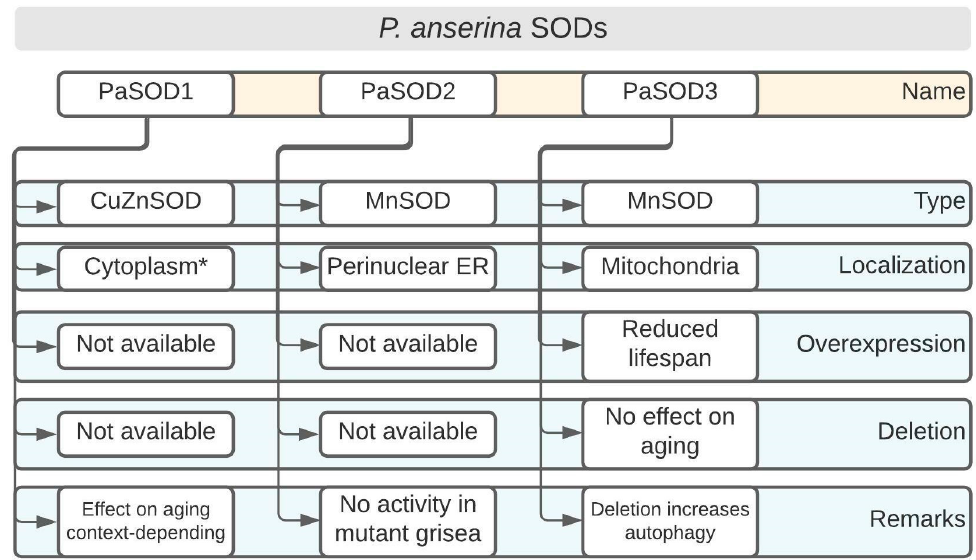
Figure 2. Podospora anserina SOD overview. * Further cellular localizations such as intermembrane space of mitochondria are likely. Overexpression and deletion denote genetic manipulations of the corresponding SOD-encoding genes. ER: endoplasmic reticulum.